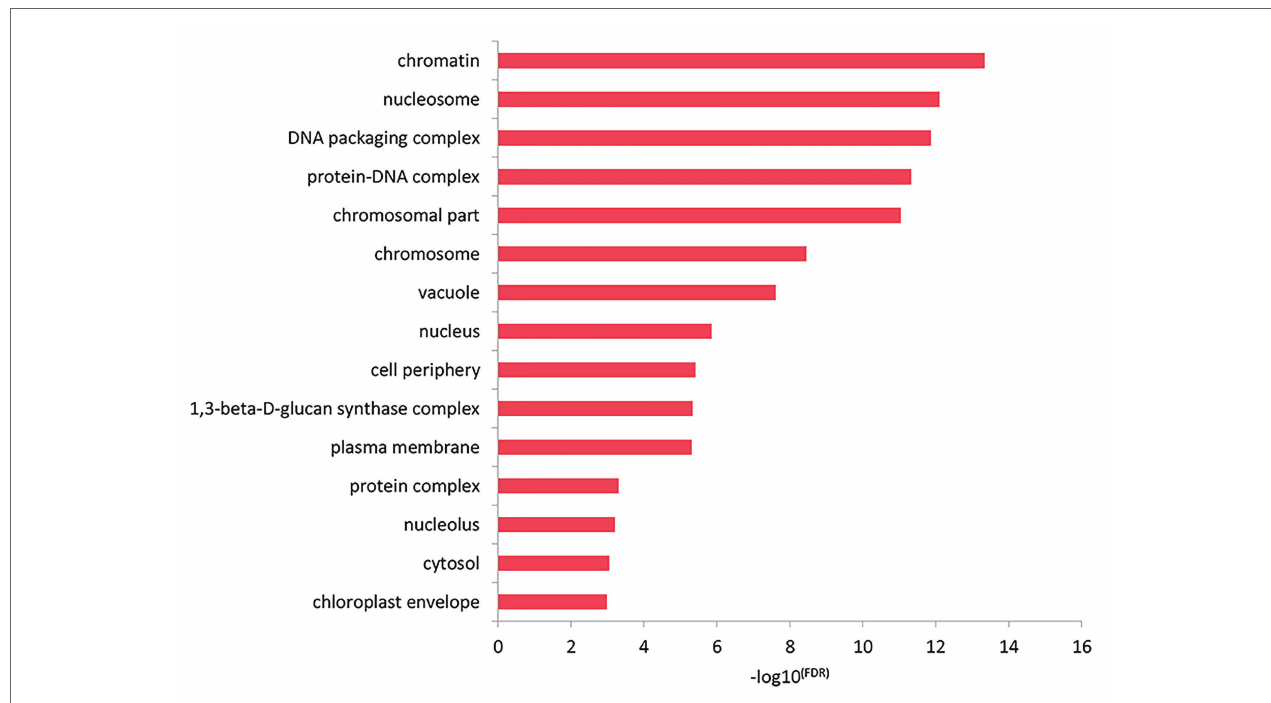
FIGURE 5 | Cell component enrichment analysis of differentially expressed genes in the top GO